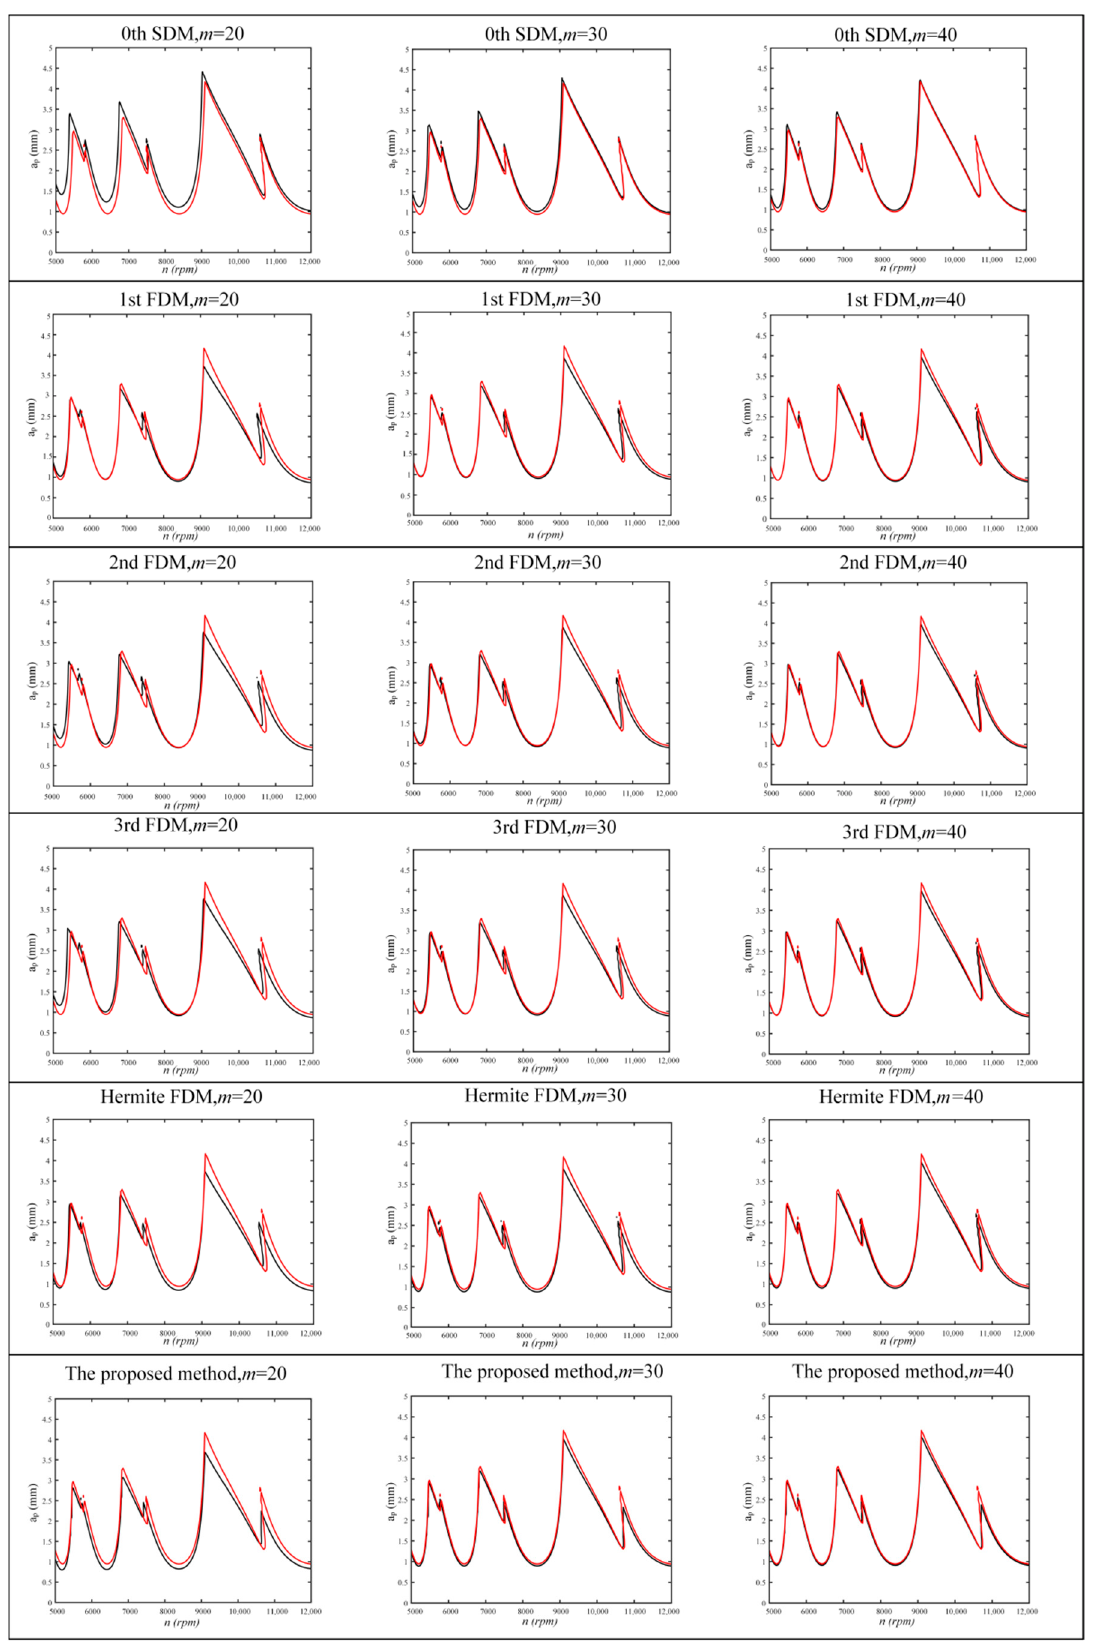
Figure 4. A comparison of computational accuracy in a/D = 0.1.